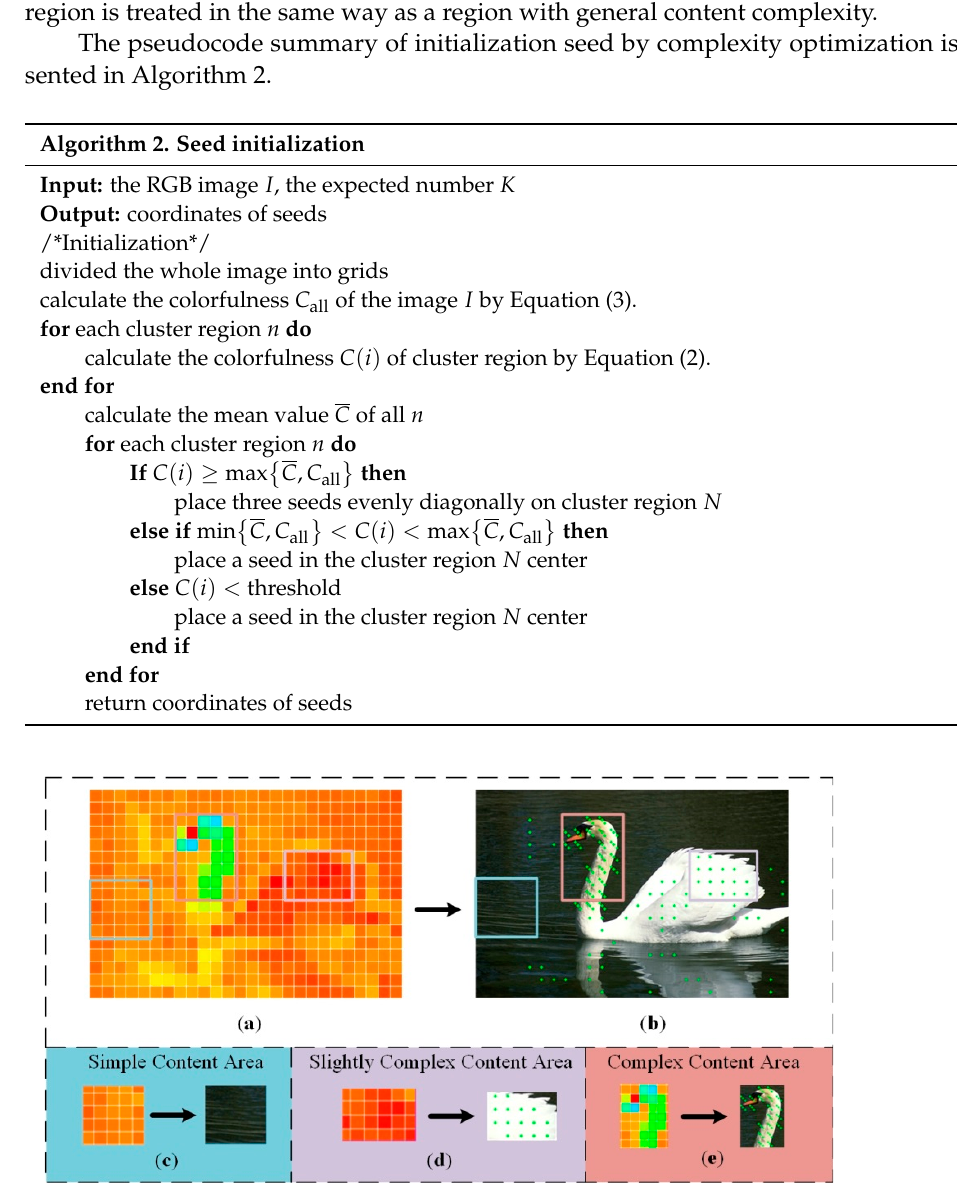
Algorithm 2. Seed initialization